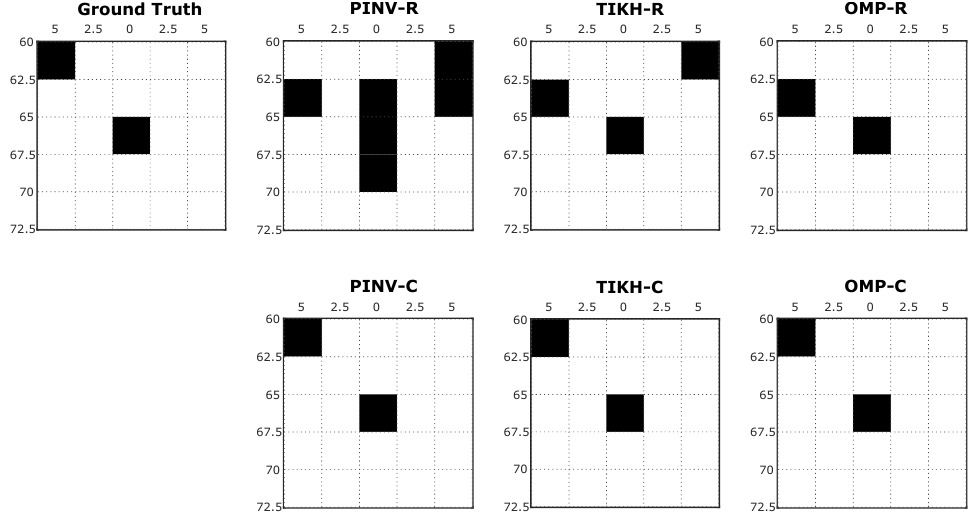
Figure 11. Examples of reconstructed image with two obstacles in the environment after